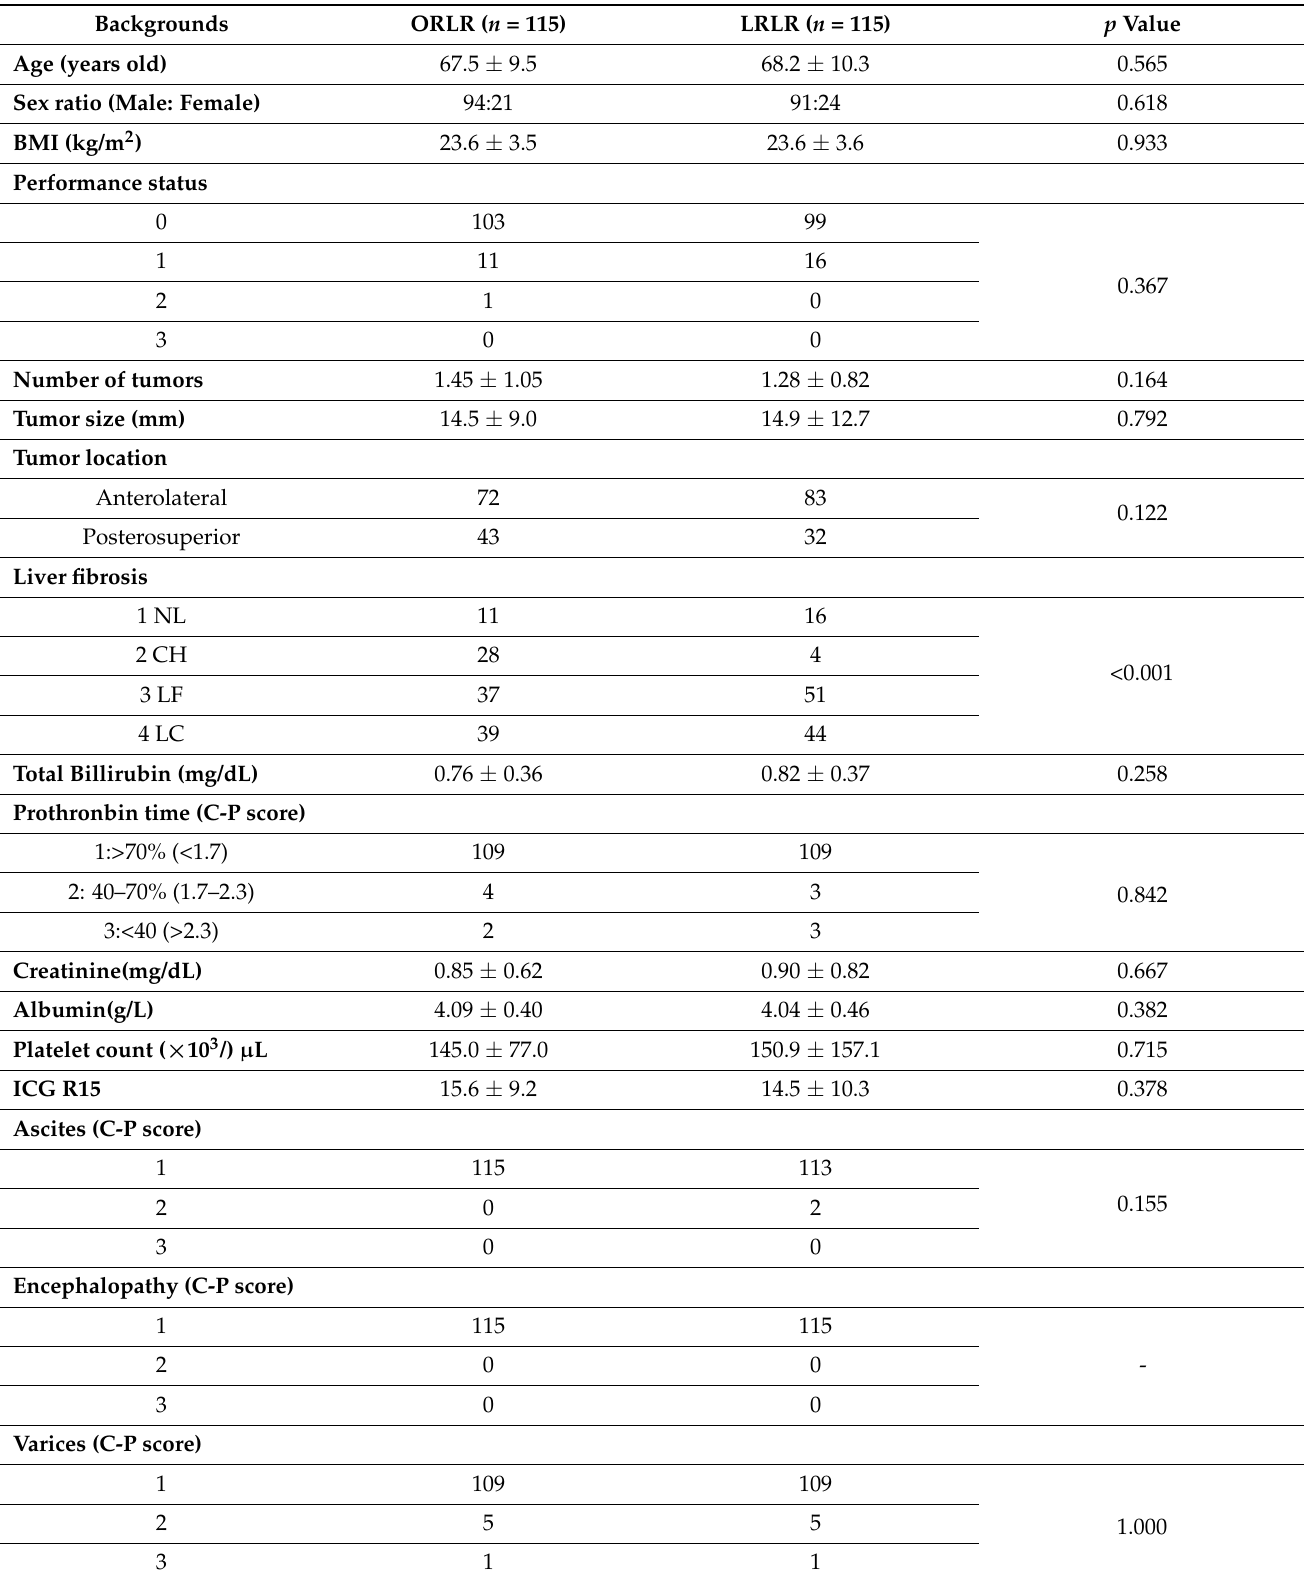
Table 3. Patient and tumor backgrounds after propensity score